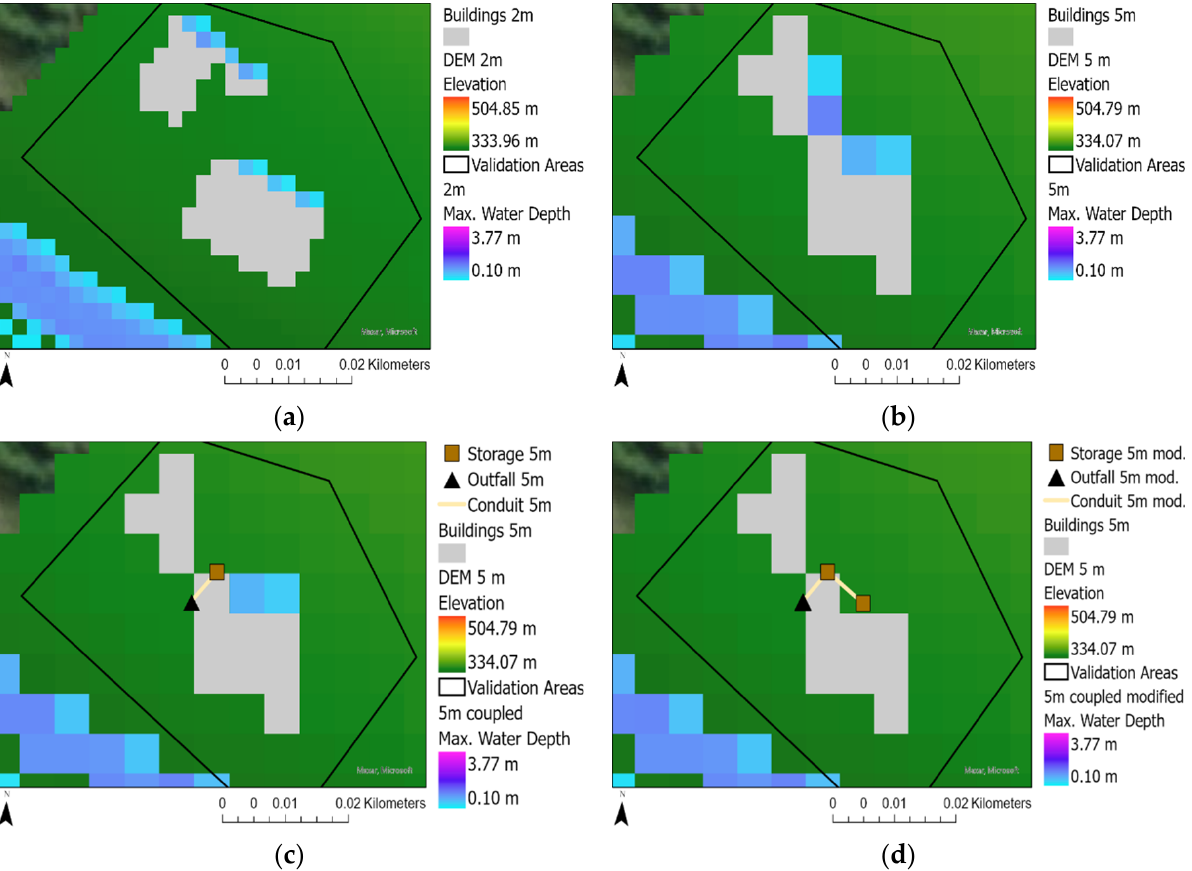
Figure 4. ( a ) Simulated max. water depth by the 2 m resolution model; ( b ) overestimation of the max. water depth by the 5 m resolution model due to incorrect water accumulation; ( c ) improved simulated max. water depth by the 5 m model with automatized placement of virtual channels; ( d ) further improvement of the simulated max. water depth by the 5 m model after manual refinement.